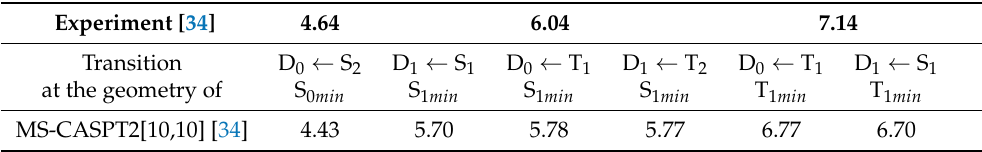
Table 1. Experimental and theoretical ionization energies (IE) of acetylacetone to the first ionic state (in eV) for the investigated